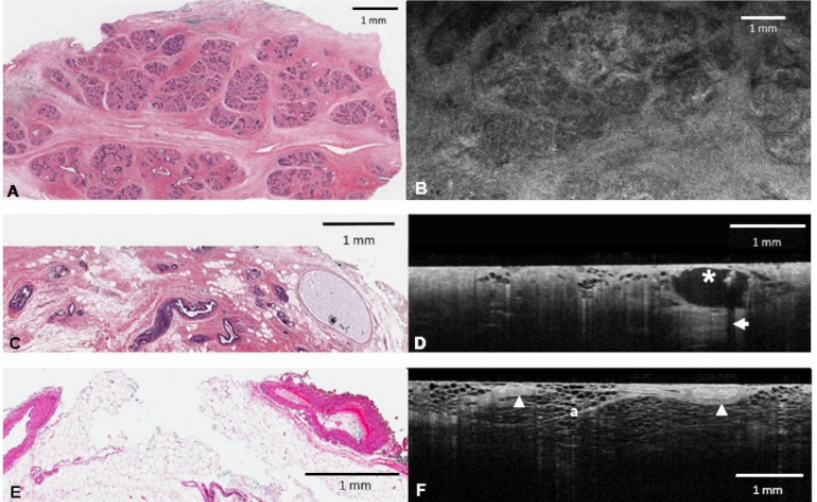
Figure 1. OCT appearance of benign breast tissue entities. ( A ) H & E slide of numerous duct lobules within a hamartoma. ( B ): En face OCT image of hamartoma showing hypo-reflective clusters of lobules with delicate, interdigitating stroma. ( C ): H & E slide of cystically dilated duct (on right side) containing calcification. ( D ): Corresponding, cross-sectional OCT image showing a well-demarcated cyst with hypo-reflective/black interior and hyper-reflective internal calcification (asterisk). Posterior shadow (arrow) beneath calcification. ( E ): H & E slide of arterial vessels. ( F ): Corresponding cross- sectional OCT image showing vessels (arrow heads) within adipose tissue (a). Notice bright smooth muscle layer and surrounding gray